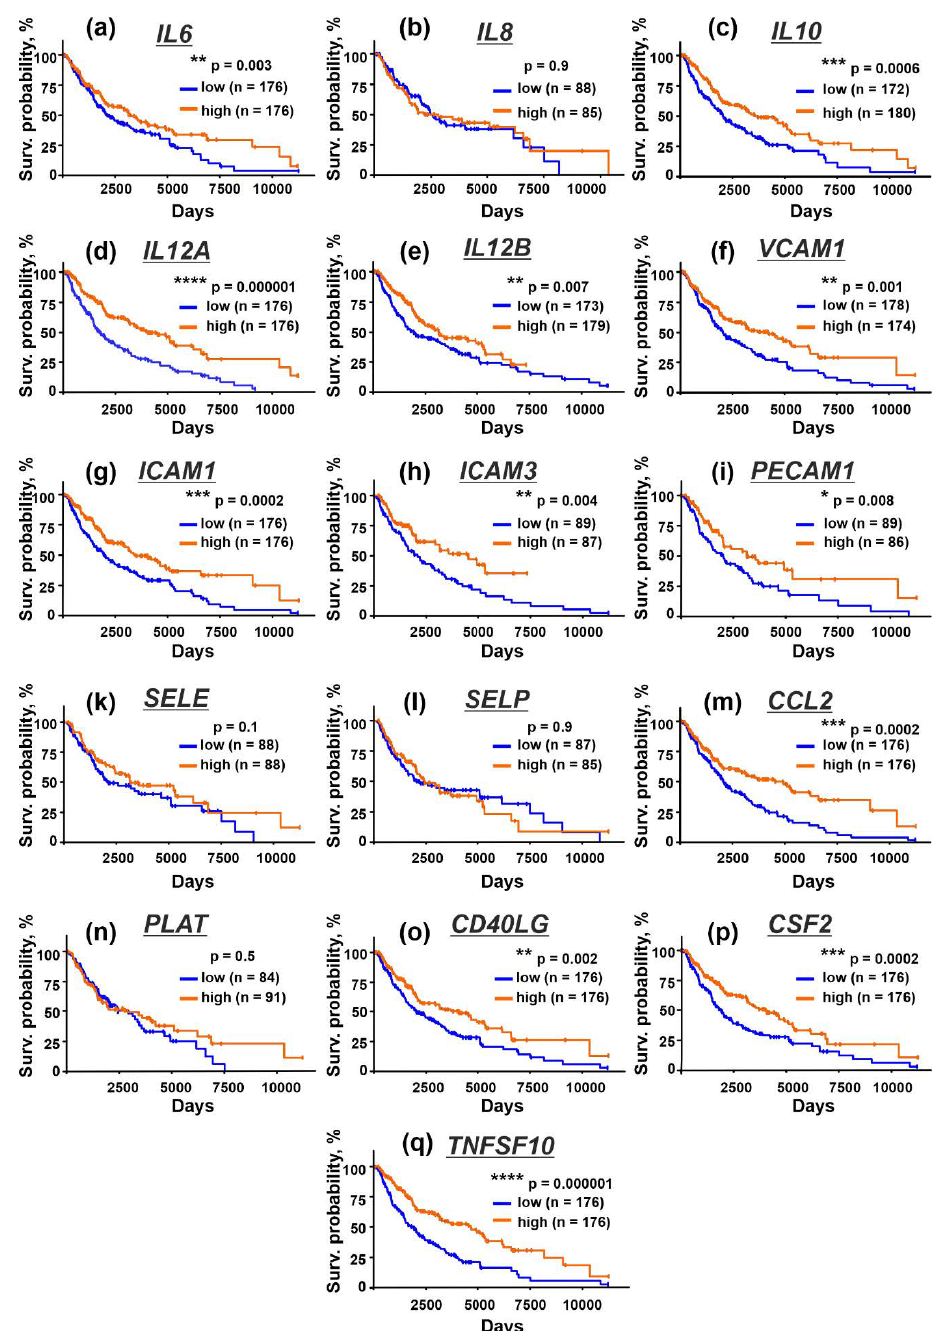
Figure 8. Kaplan–Meier analysis of the correlation between the survival of the patients with metastatic melanoma and the different expression of the genes coding IL6 ( a ), IL8/CXCL8 ( b ), IL10 ( c ), IL12A ( d ), IL12B ( e ), VCAM1 ( f ), ICAM1 ( g ), ICAM3 ( h ), PECAM1 ( i ), SELE ( k ), SELP ( l ), CCL2 ( m ), PLAT ( n ), CD40LG ( o ), CSF2 ( p ), and TNSF10 ( q ). * ( p <0.05), ** ( p < 0.01), *** ( p < 0.001), and **** ( p < 0.0001) indicate significant difference between the overall survival prognosis for the patients with the high (above median) and low (below median) gene expression according to the log-rank test.